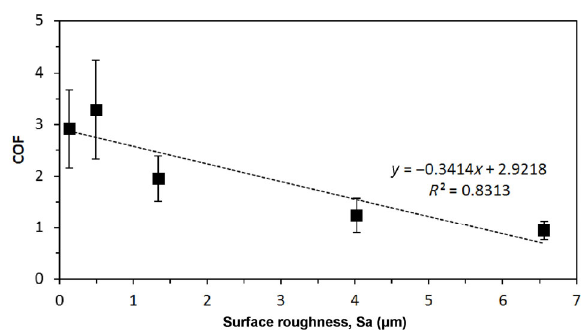
Fig. 8 COF versus measured 3D surface roughness